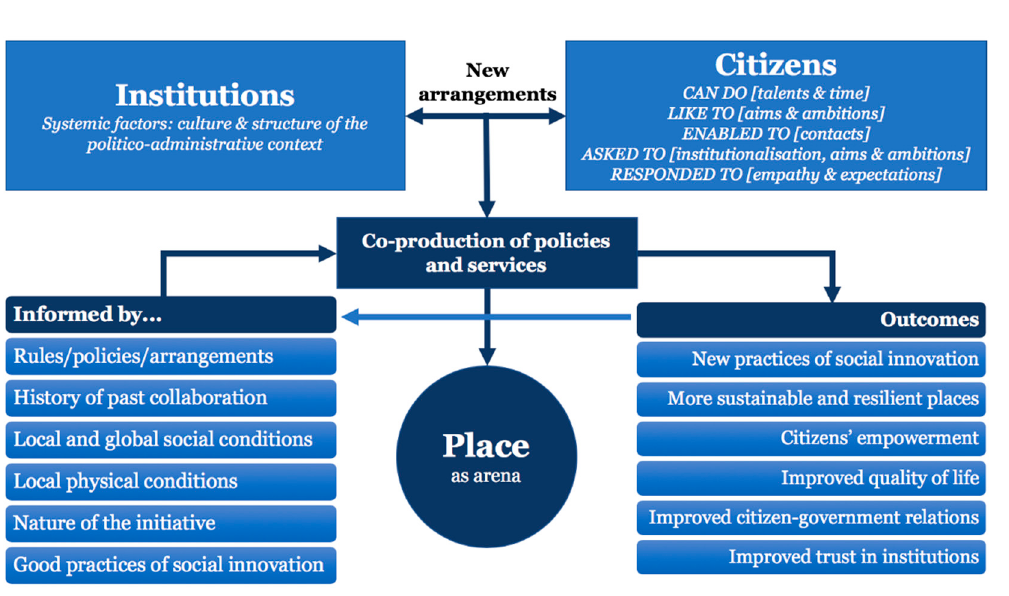
Figure 1. PlaCI: Conceptual model of citizen initiatives and their role in shaping sustainable places.